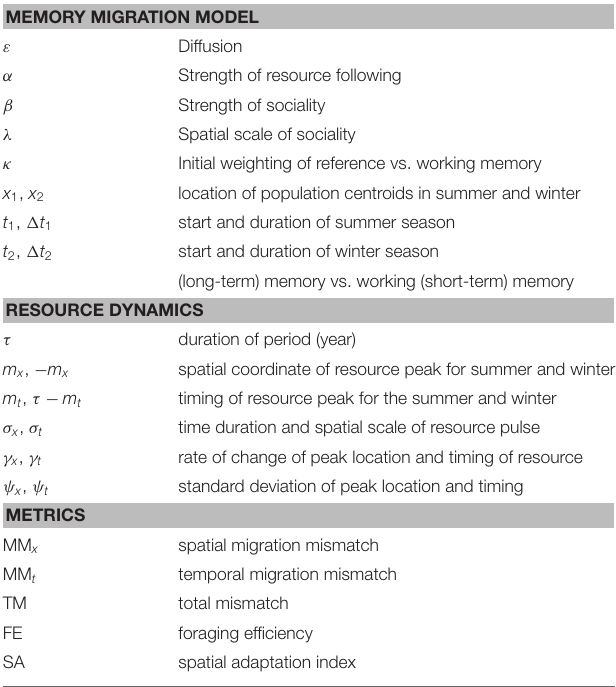
TABLE 1 | Table of parameters, variables and